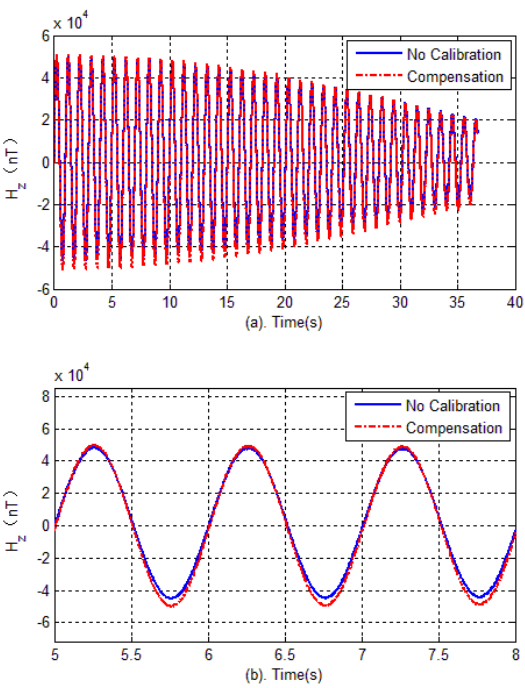
Figure 22. Magnetometer outputs of Z-axis. Figure 23. Outputs error versus time.